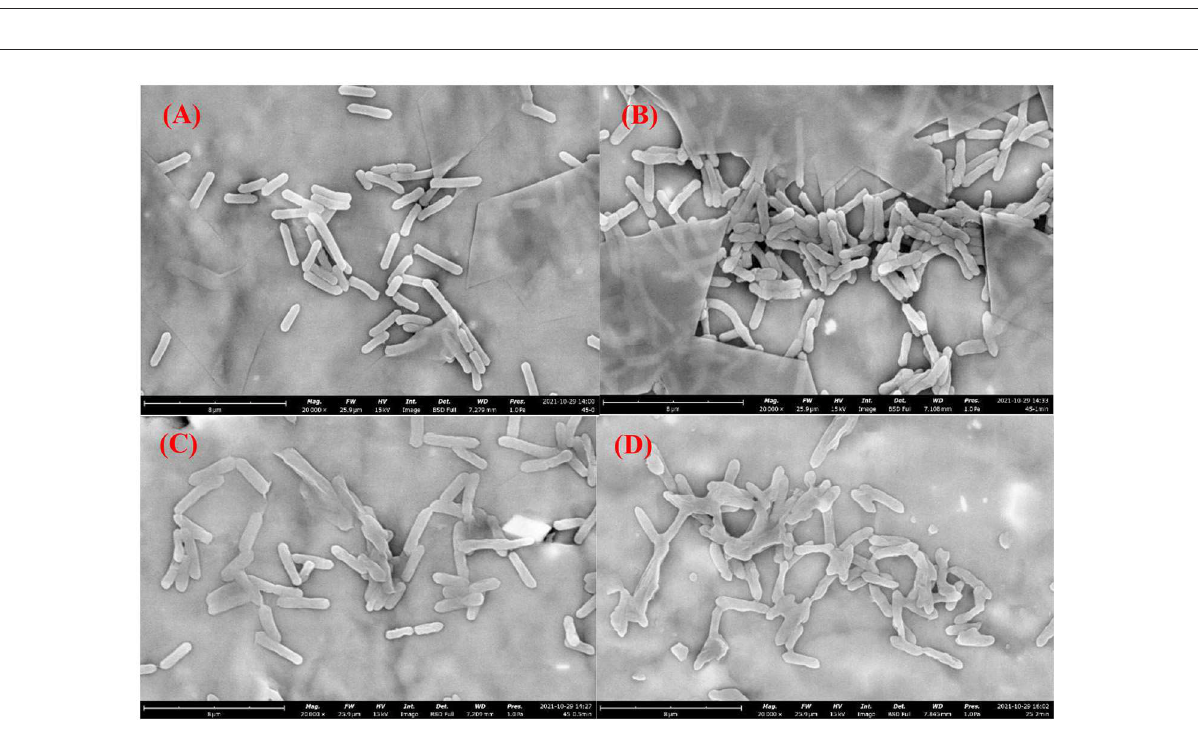
FIGURE4 Morphological images of Alicyclobacillus acidoterrestris cells growth at 45 ◦ C exposure to DBD-plasma at 30 kV for 0 (A) , 0.5 (B) , 1.0 (C) and 2.0min (D) , respectively.